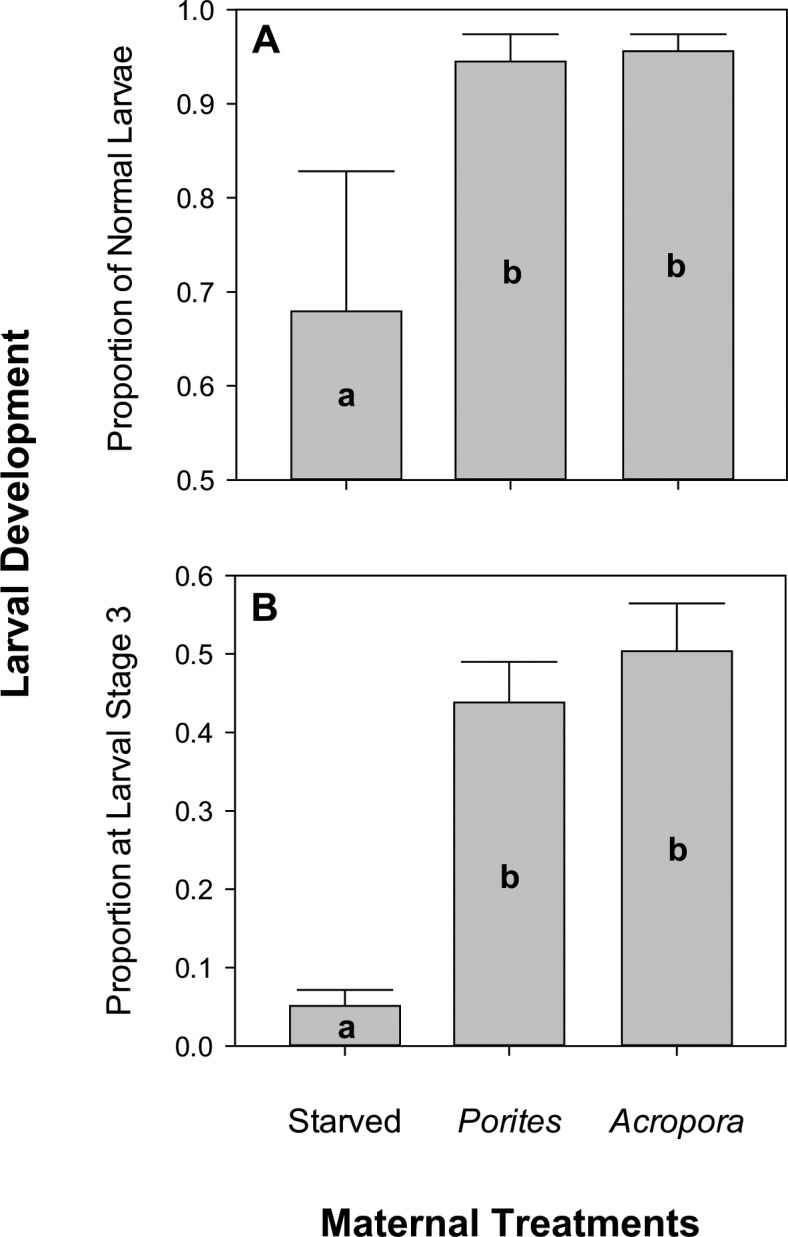
Proportion of (A) normal larvae and (B) late bipinnaria / early brachiolaria larvae at day eight. Error bars represent + 1SD and n = 9 for each maternal treatment. Different letters are significantly different based on Tukey’s post hoc tests.